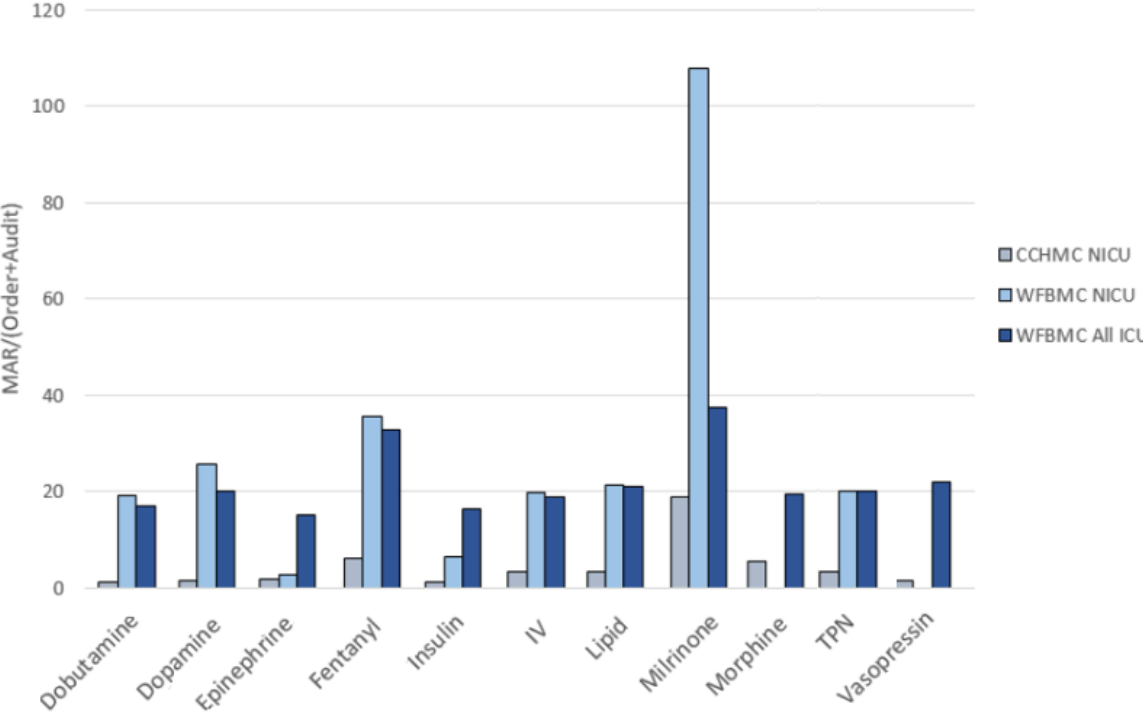
Figure 3. Comparison of MAR/(order + audit) ratios between the CCHMC NICU, the WFBMC NICU, and WFBMC All ICUs. CCHMC: Cincinnati Children’s Hospital Medical Center; ICU: intensive care unit; MAR: medication administration record; NICU: neonatal intensive care unit; WFBMC: Wake Forest Baptist Medical